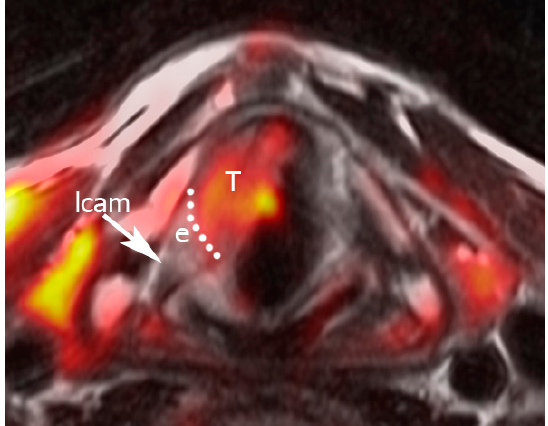
Figure 4. Example of Pattern B, indicating fusion between a T2-weighted sequence and a diffusion-weighted imaging (DWI) image. “Hot” areas correspond to the anterior glottic tumor. A dotted line separates the tumor from the peritumoral edema. The lateral cricoarytenoid muscle is normal. Legend: e, edema; lcam, lateral cricoarytenoid muscle; T, tumor.